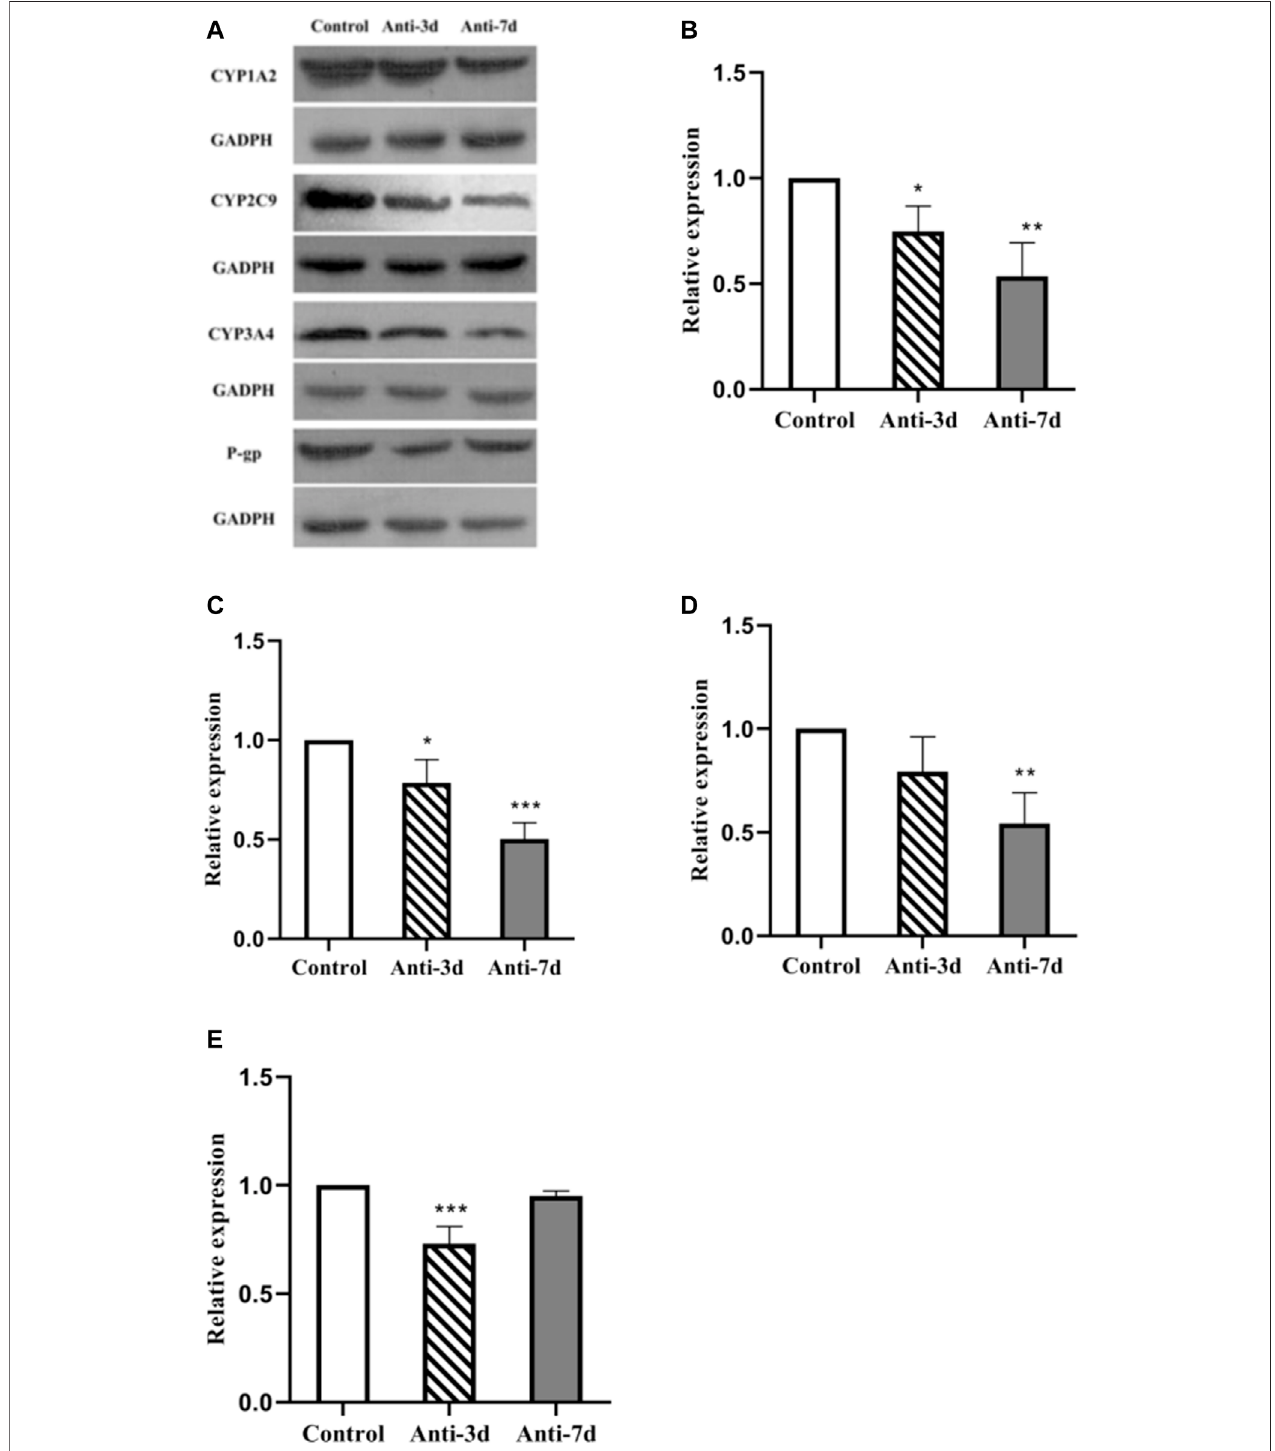
FIGURE 5 | Effect of an intestinal fl ora imbalance on liver drug enzymes and P-gp protein expression in the terminal ileum. Antibiotics were used to intervene the intestinal fl ora ofratsfor 3and 7 days respectively, and west-blot wasused todetect the protein expression levelsofliver drugenzymesand P-gp. The levelofCYP1A2, CY2C9, CYP3A4, and P-gp protein expression were shown in (A) . And the gray analysis results are shown in CYP1A2 (B) , CYP2C9 (C) , CYP3A4 (D) in the liver, and P-gp (E) in the ileum. *** p < 0.0001; ** p < 0.005; * p < 0.05. The intervention groups were compared with the control group.